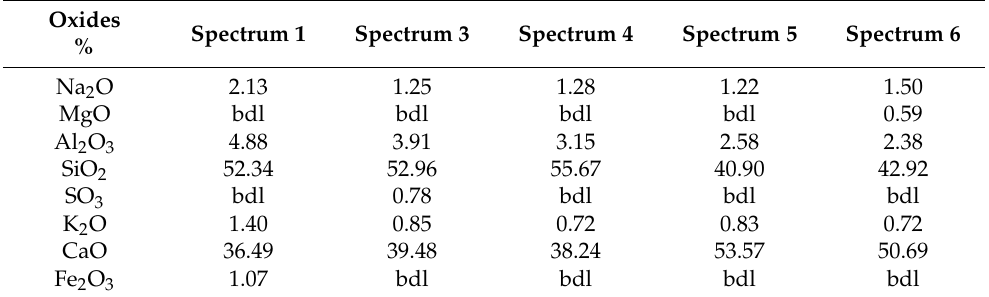
Figure 5. Microphotographs of reaction rim of microcrystalline silica (flint) in the mortar of the core of the pillar of the Augusto bridge near Narni (27 BC) under ( a ) PLM, xpl, and ( b ) EDS map of Si and and ( c ) BS image with reported areas and spots analyzed with EDS (for results, see Table 4). Table 4. Microchemical analyses of reaction rim portions and binder of Narni sample.